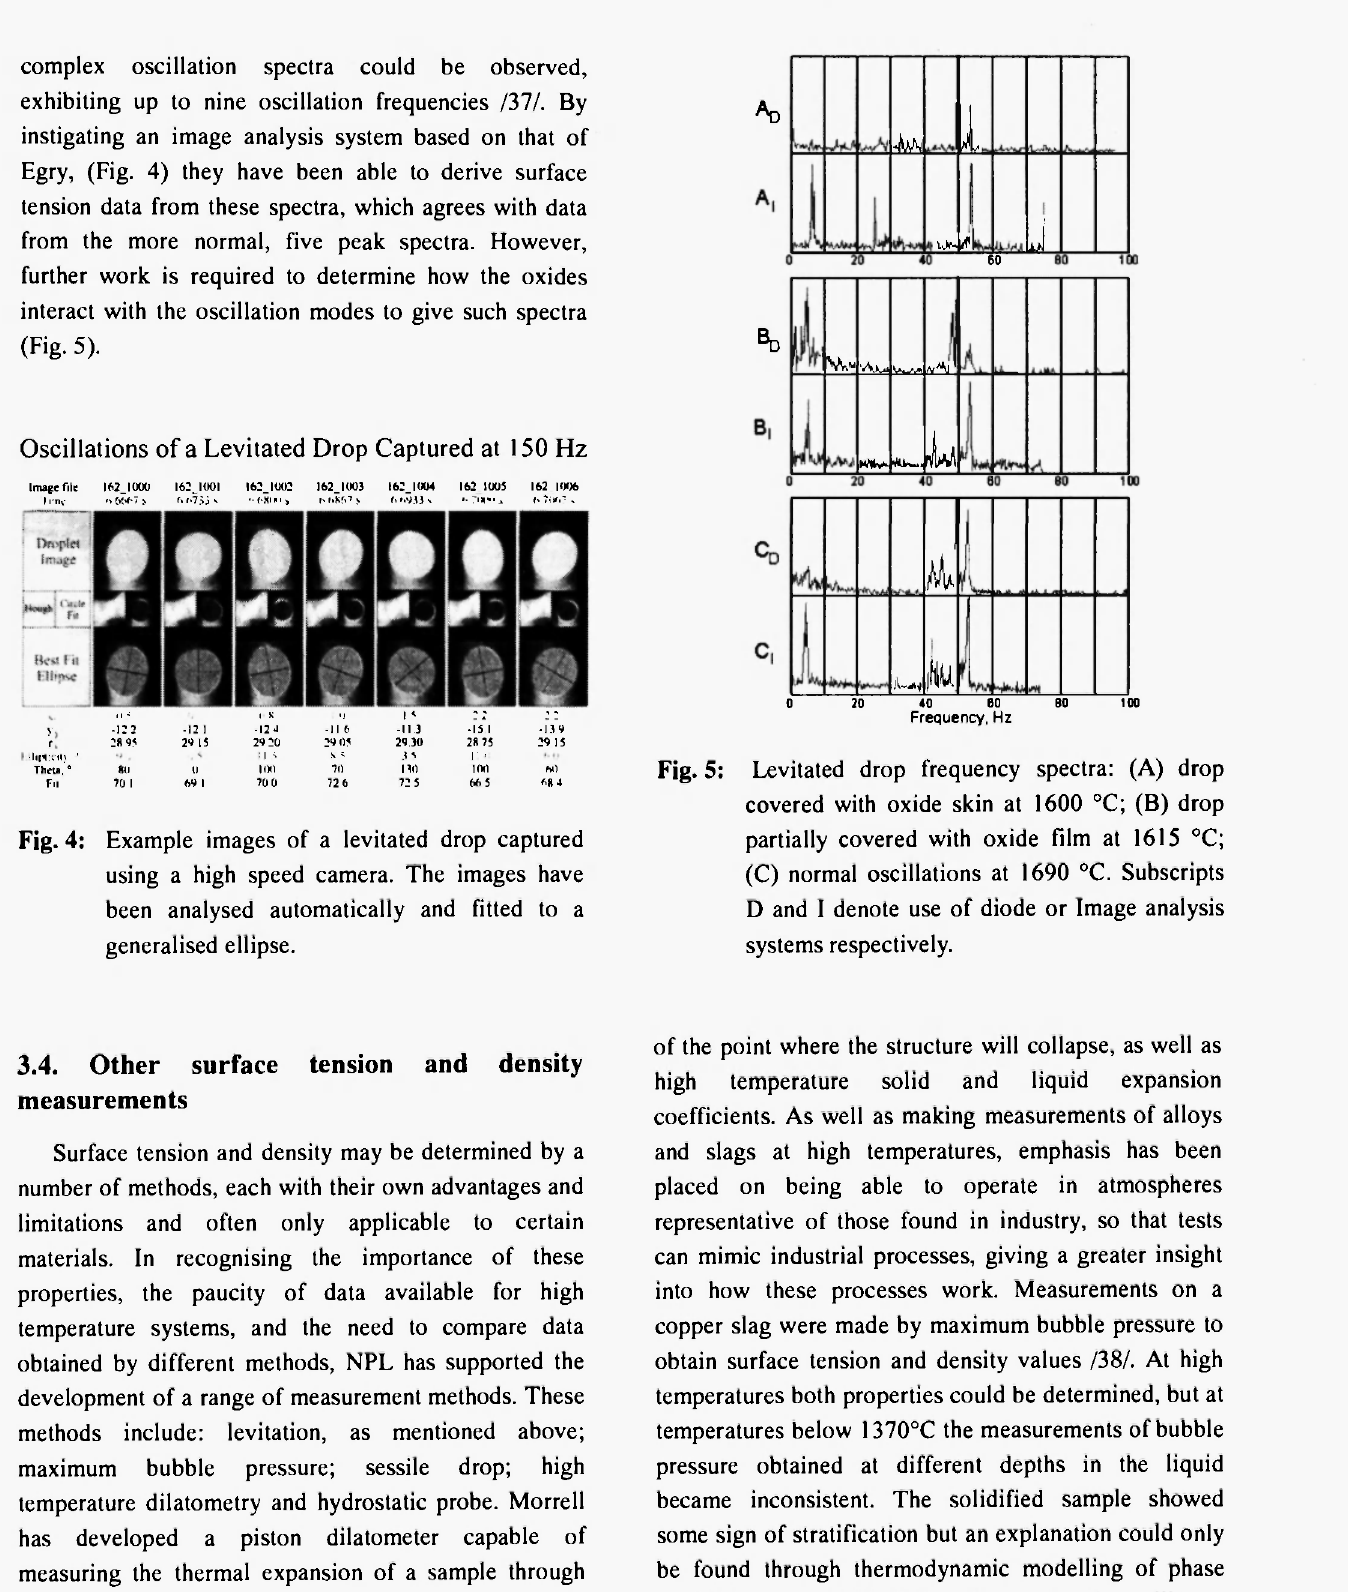
Levitated drop frequency spectra: (A) drop covered with oxide skin at 1600 °C; (B) drop partially covered with oxide film at 1615 °C; (C) normal oscillations at 1690 °C. Subscripts D and I denote use of diode or Image analysis systems